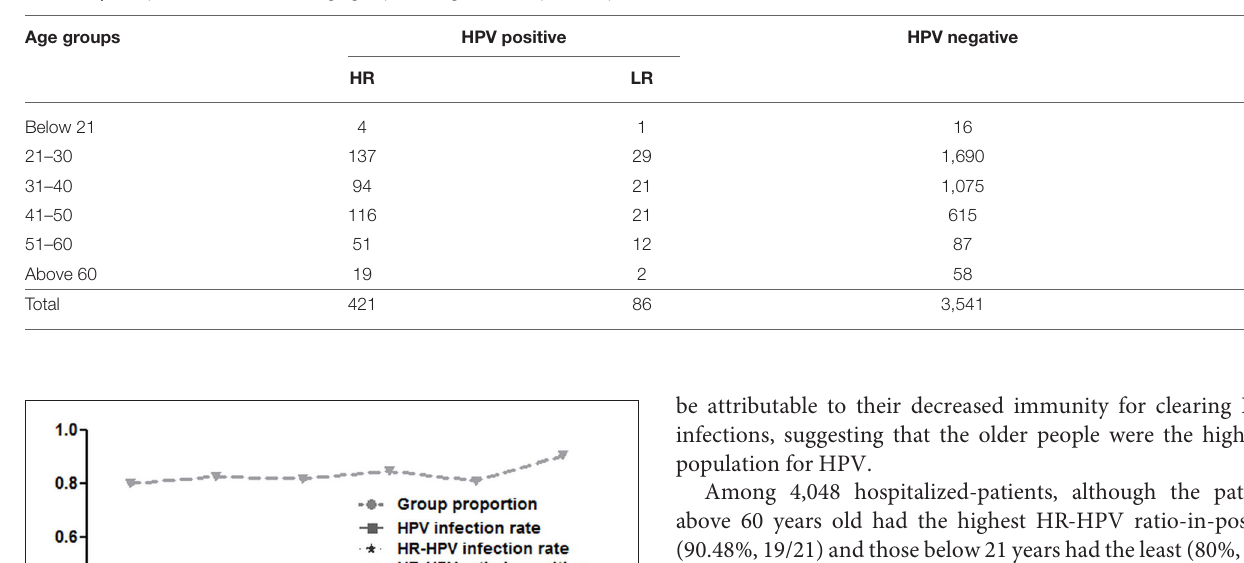
TABLE 2 | HPV prevalence of different age groups among 4,048 hospitalized-patients.